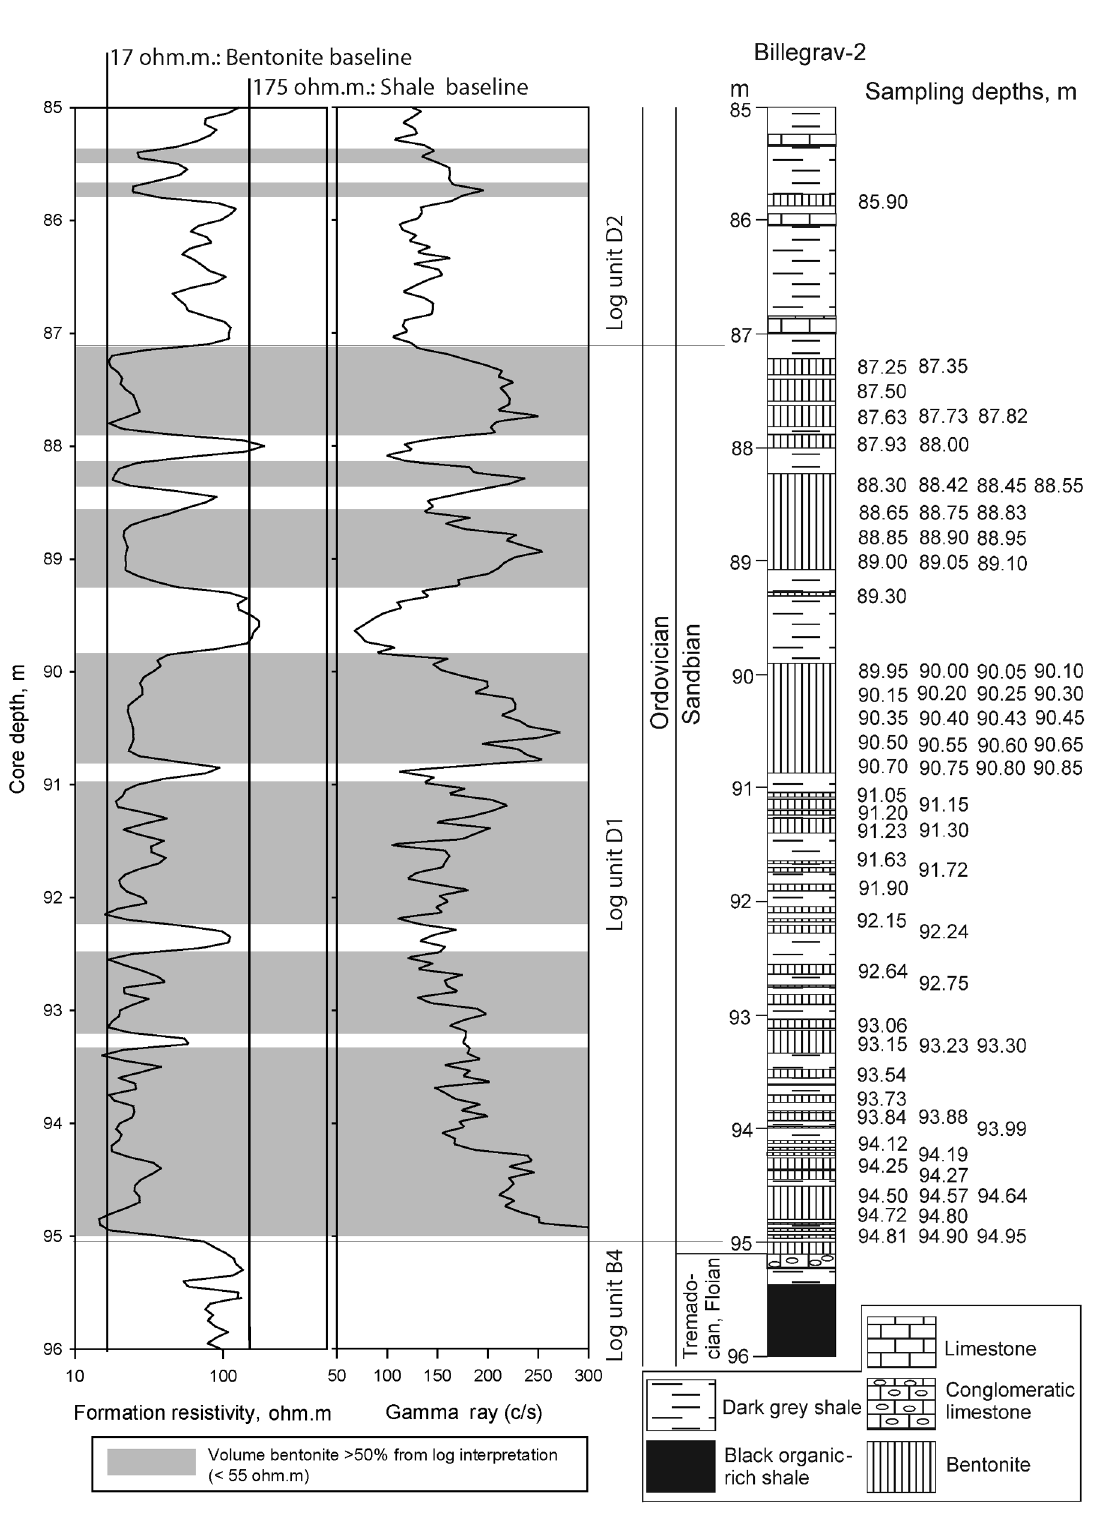
Fig. 2. Log data, lithology and sampling depths of the Billegrav-2 core